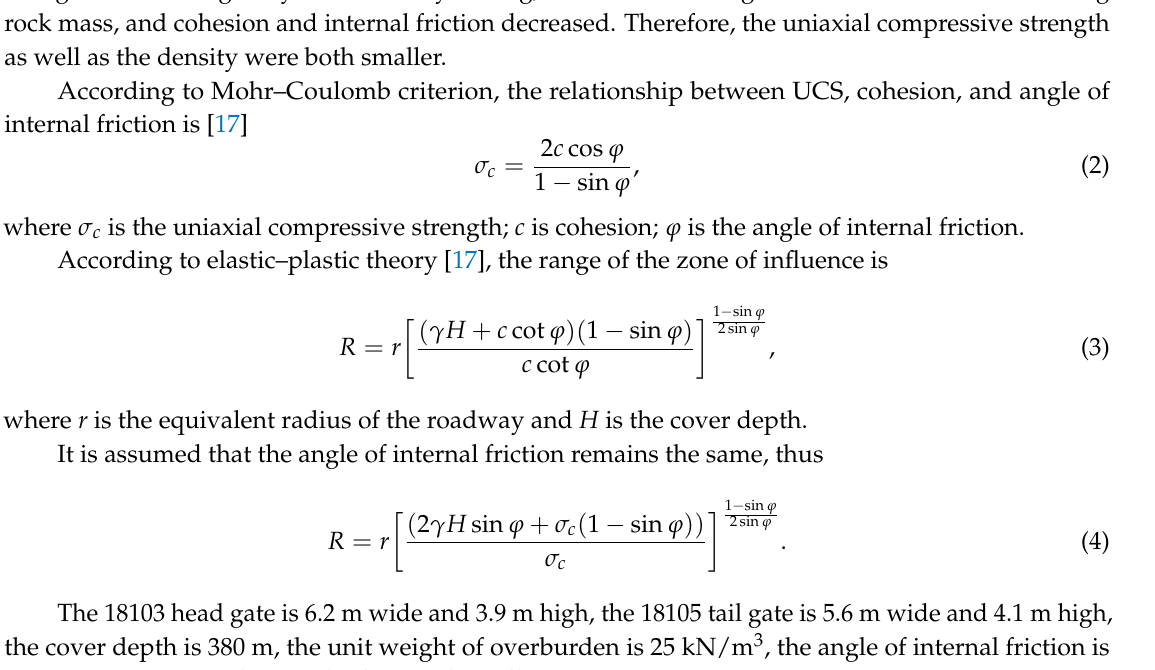
Figure 7. Uniaxial compressive strength (UCS) of coal specimens at different locations.